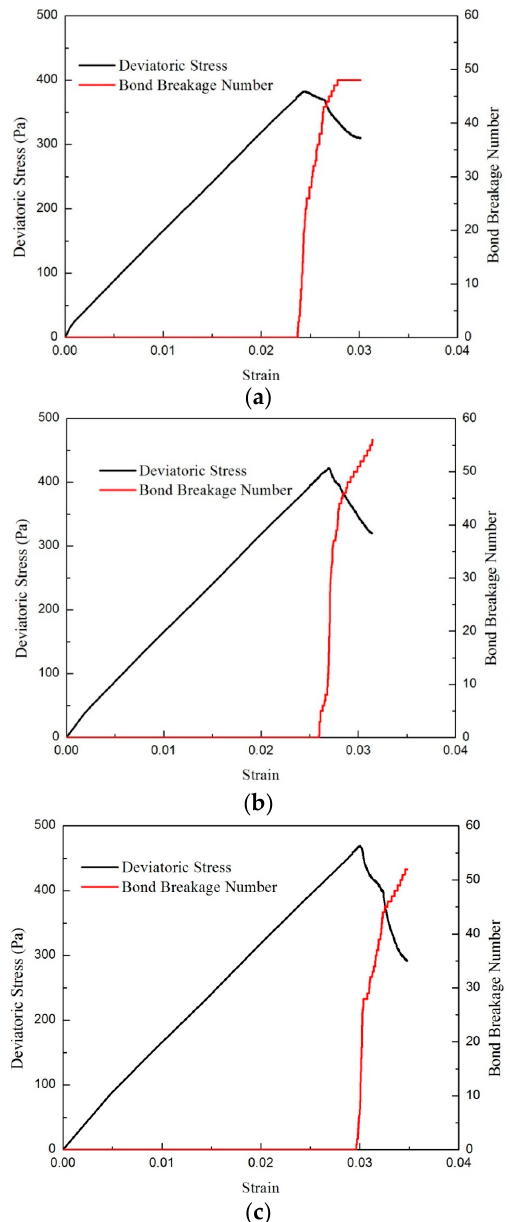
Figure 8. The deviatoric stress–strain response and number of accumulative bond breakage during biaxial compression: ( a ) bonding strength is 0.0078 N; ( b ) bonding strength is 0.039 N; and ( c ) bonding strength is 0.078 N.